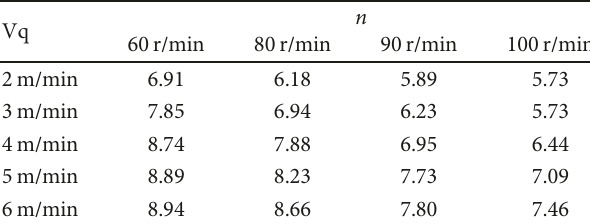
Figure 7: Relationship between the coal stress and the kinematic parameters. Table 4: Statistical value of coal stress